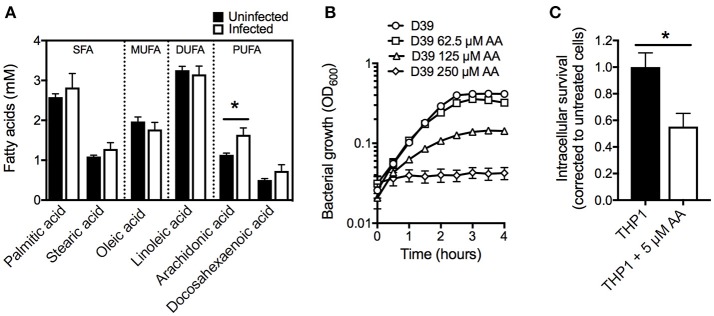
Examination of arachidonic acid as an anti-pneumococcal agent. (A) Examination of plasma fatty acids before and after infection with S. pneumoniae strain D39. (B) Examination of pneumococcal growth upon treatment with AA at 62.5, 125, or 250 μM. The OD600 was determined every 30 min. (C) Intracellular survival of pneumococci within THP-1 derived macrophages treated with 5 μM AA by comparison with untreated macrophages. All data are the mean of at least biological triplicates (±SEM) and where error bars are not visible this is due to occlusion by the shown symbols. Statistical analyses were performed using a Student's t-test (*p < 0.05).